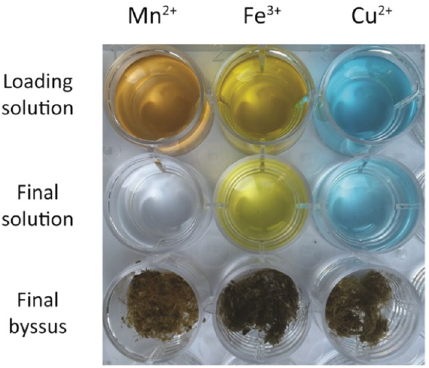
Figure 2. Camera picture of metal solutions and byssus. The 10 mM Mn 2+ , Fe 3+ , or Cu 2+ solution before and after being in contact with the byssus are reported. After the treatment, a decrease in the color intensity of the solution is observed. The byssus exposed to Fe 3+ assumed a darker coloration.